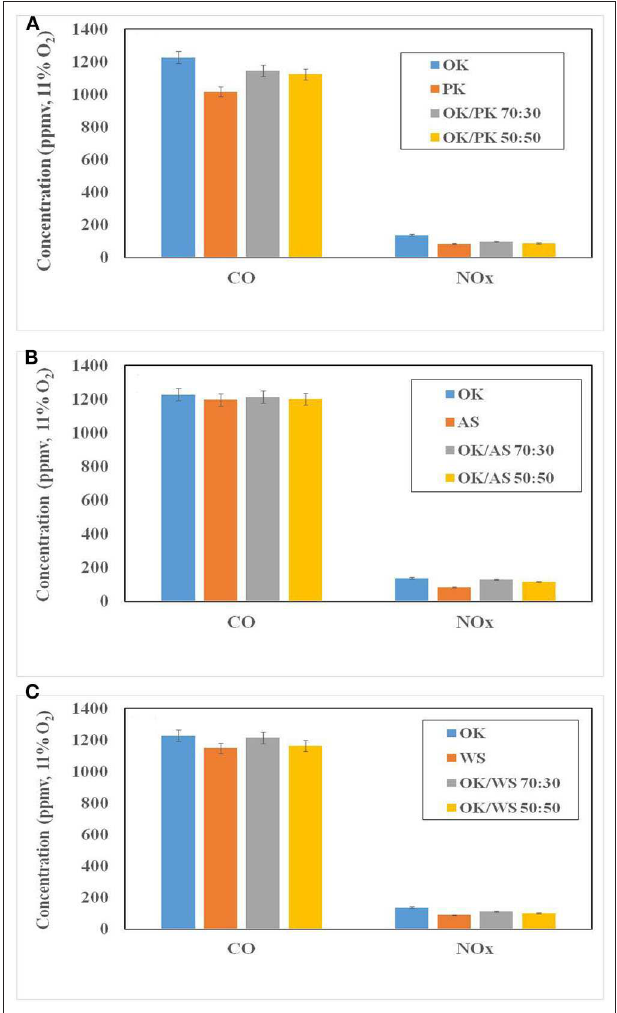
FIGURE 6 | Average CO and NO x emissions of gases at steady state from (A) OK/PK, (B) OK/AS, and (C) OK/WS mixtures.